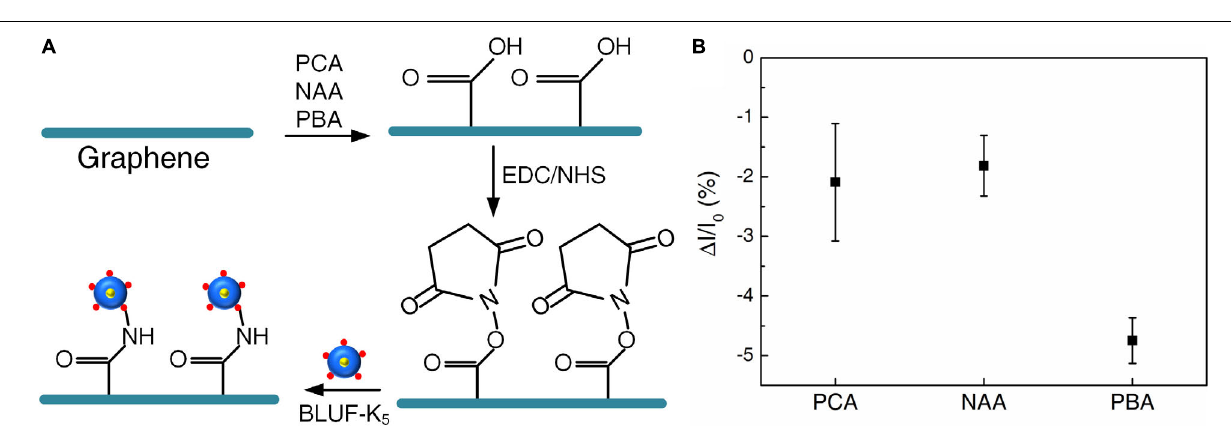
FIGURE 2 | (A) The surface modification process by different carboxyl molecules: PCA, NAA, PBA. (B) Photocurrent responses of the devices under 450 nm illumination. Bias voltage is 10